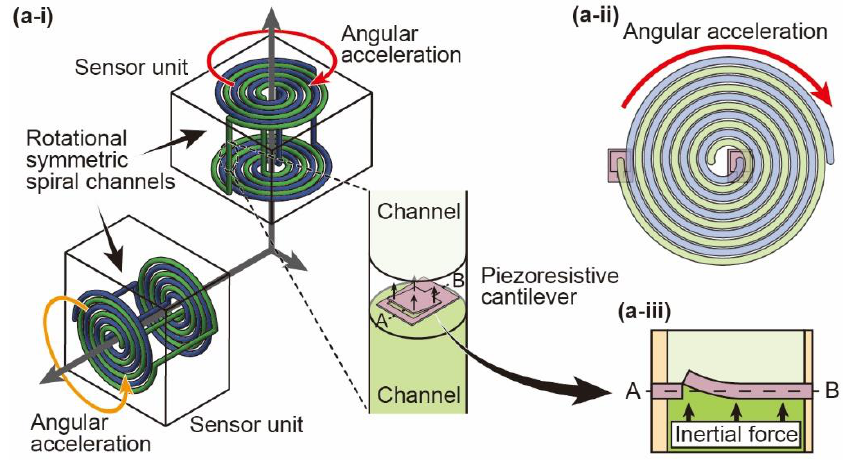
Figure 1. Proposed sensor configuration. ( a-i ) Schematic image of the proposed sensor and enlarged view of the channel connection, ( a-ii ) top-view schematic image of the rotational-symmetric spiral channels, and ( a-iii ) cross-sectional view of the piezoresistive cantilever deformation due to inertial force.